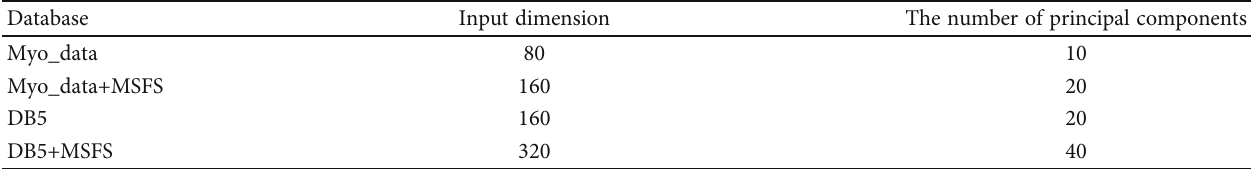
Table 4: Dimensionality reduction results.